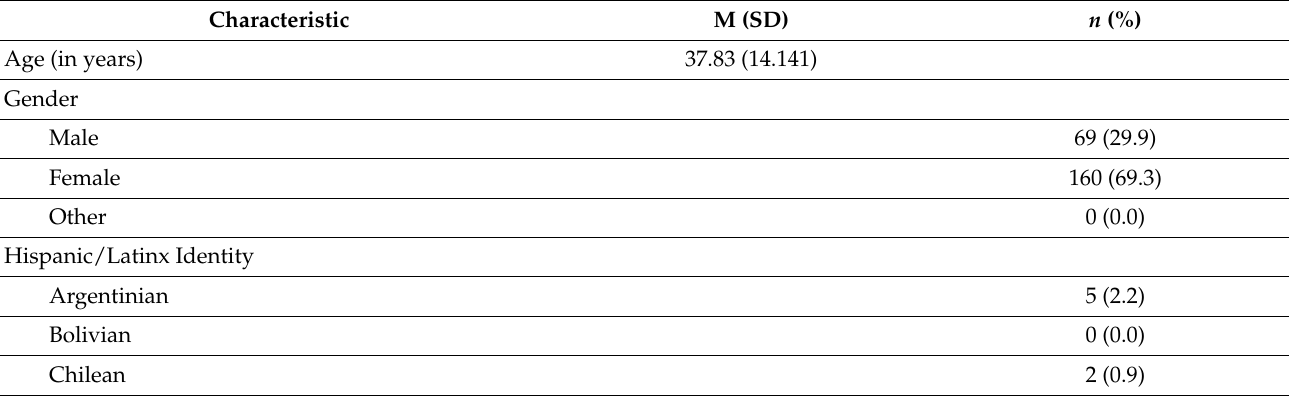
Table 1. Descriptive characteristics of the study sample ( n =